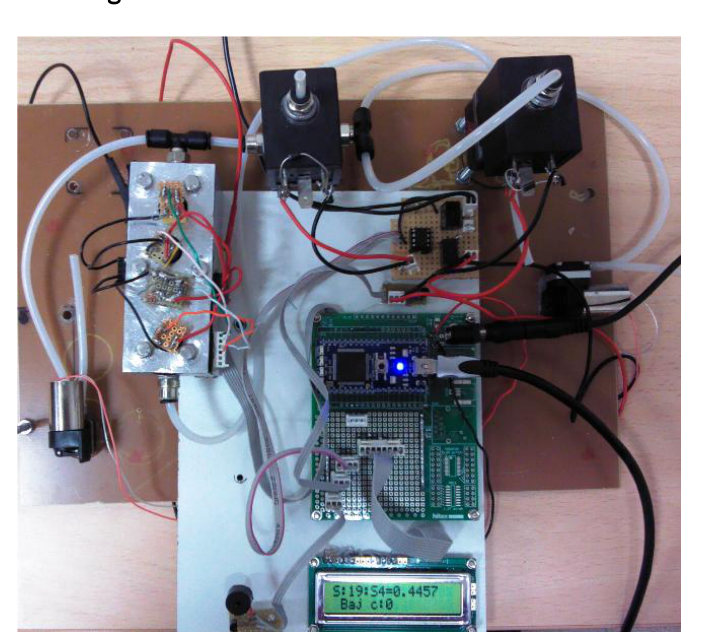
Figure 2. View of the mbed electronic